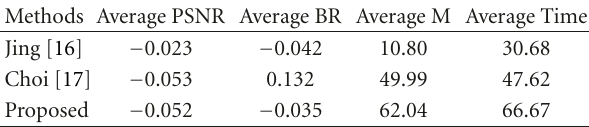
Table 3: Average results of proposed and compared algorithms.